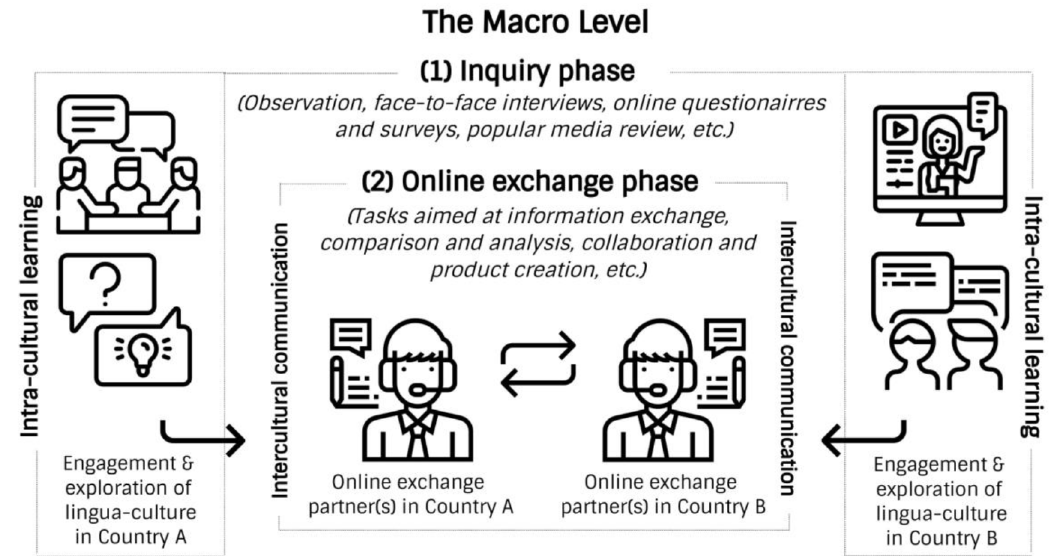
Figure 2. The inquiry-based model of telecollaboration (macro